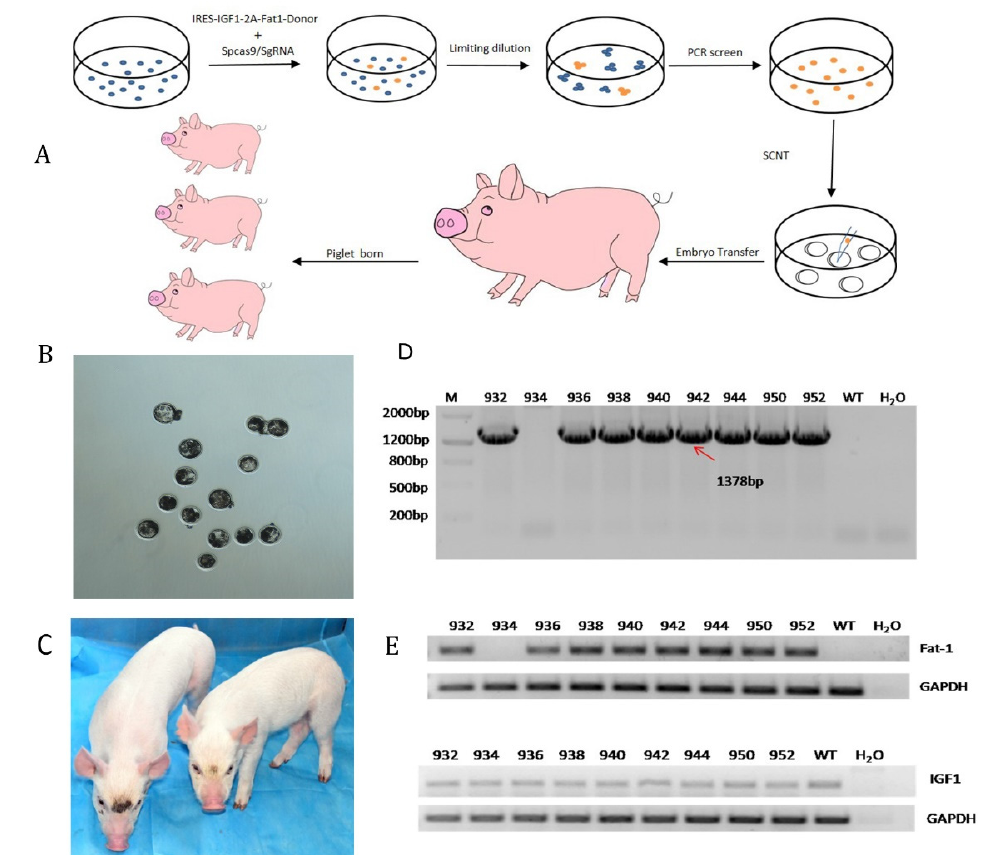
Figure 2. Generation and genotype identification of F0 transgenic piglets. ( A ) Flow chart of the experimental procedures for preparing IGF-1 and Fat-1 knock-in pigs. ( B ) To assess blastocyst development in vitro, the reconstructed embryos were cultured to the blastocyst stage in vitro. ( C ) Photo of F0 three-day-old piglets with site-specific IGF-1 and Fat-1 gene knock-in. ( D ) PCR analysis of IGF-1 and Fat-1 knock-in pigs using the primers 1F/1R (mentioned above): M: DNA 2000, WT: negative control, H 2 O: blank control. ( E ) RT-PCR analysis of IGF-1 and Fat-1 positive pigs using the primers 2F/R and 3F/R, respectively.